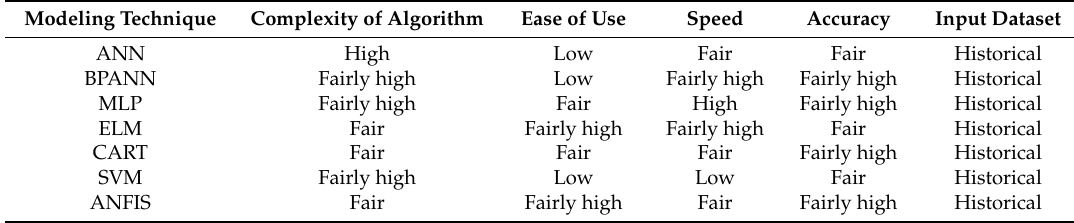
Table 2. Comparative analysis of single ML models for the prediction of short-term floods. Modeling